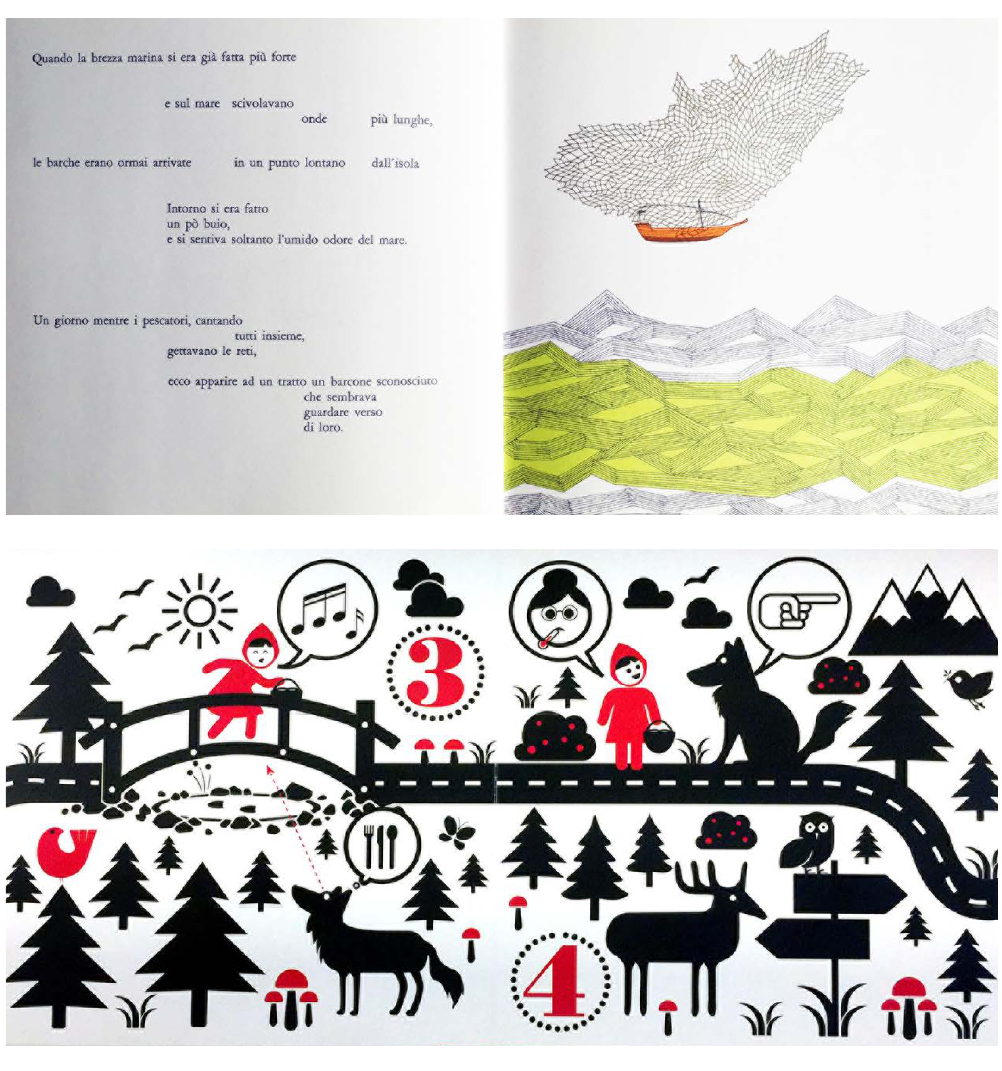
Fig. 16 Aoi Huber-Kono, Il grande pesce , 2007. Fig. 17 Sandro Natalini, Cappuccetto Rosso ,